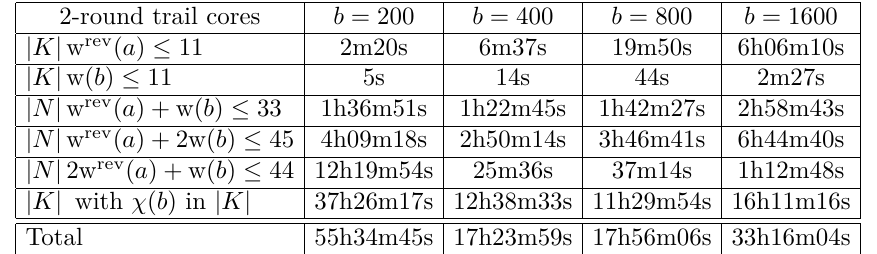
Table 5: Execution time for the generation of 2-round trail cores. Last line refers to the technique of [DV12].